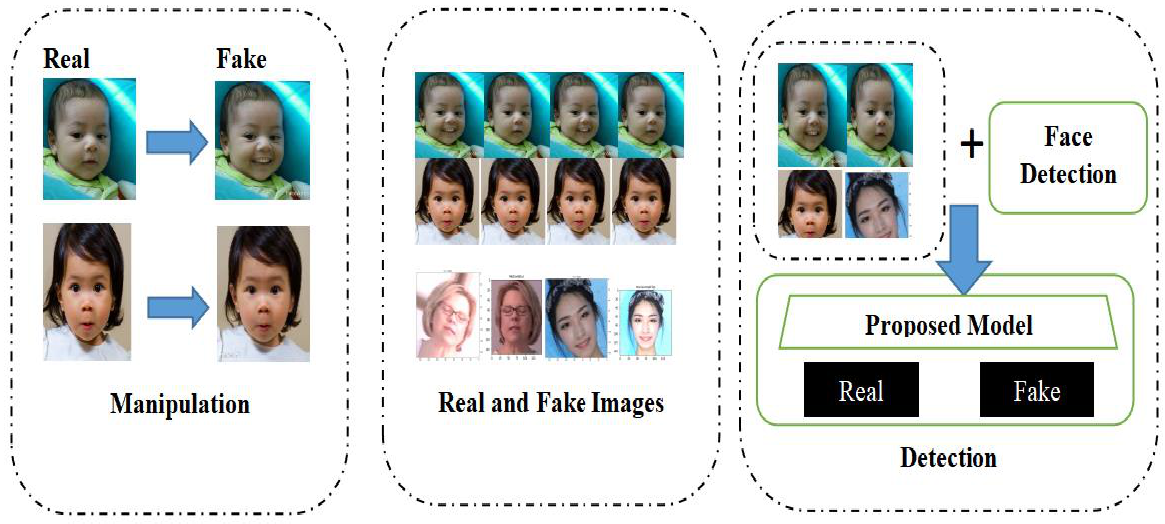
Figure 1. High Level view of deepfake creation and detection model.